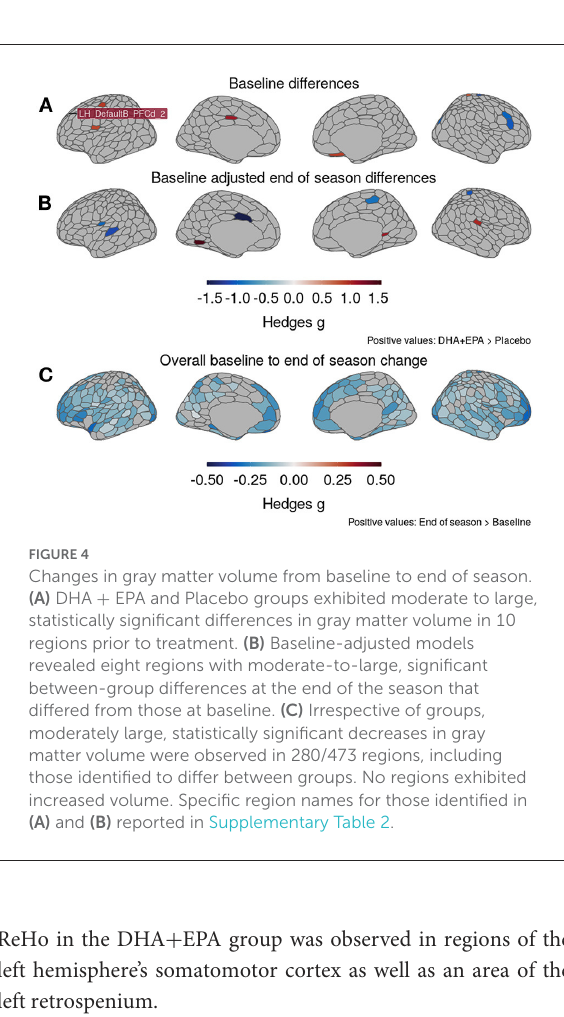
ReHo in the DHA + EPA group was observed in regions of the left hemisphere’s somatomotor cortex as well as an area of the left